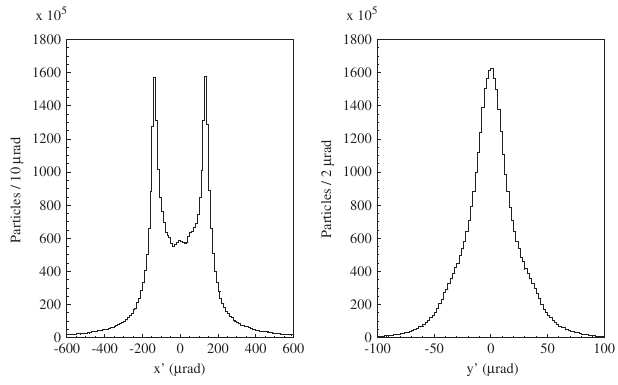
FIG. 1. Horizontal and vertical angular distributions of the CLIC disrupted beam, obtained with GUINEA-PIG using Gaussian incoming beams and normalized to one bunch.